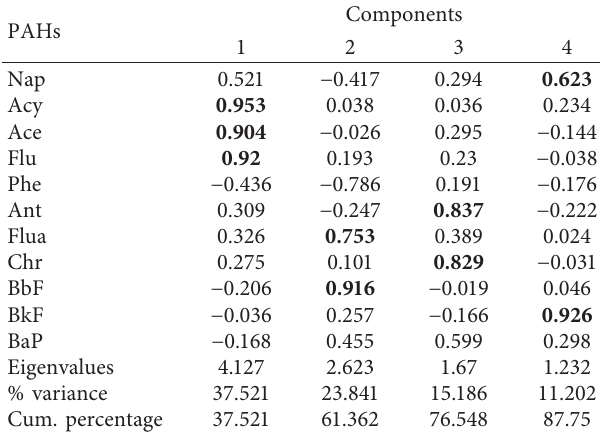
Table 3: Rotated component matrix of studied PAHs in the Yellow River (Lingwu